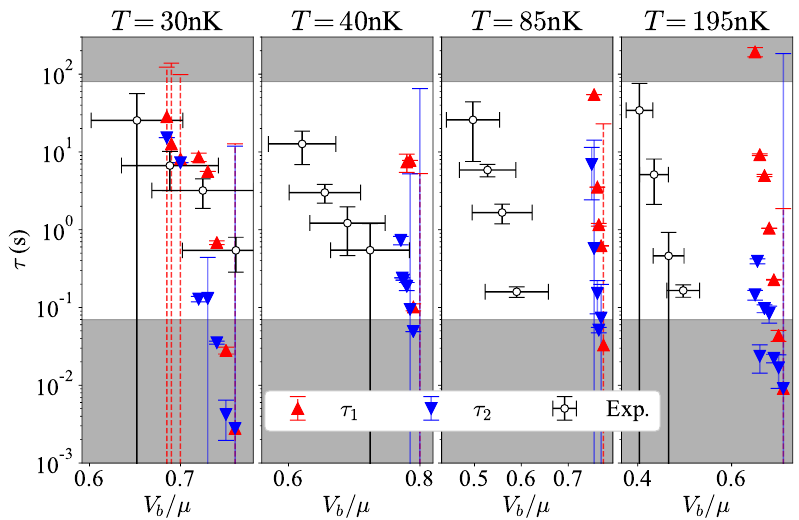
Figure 17: Slow-decay timescale τ inverted triangles) as a function of normalised barrier height κ = V give 95% confidence interval. Data points with standard deviation in τ greater than 10 2 s are excluded from this